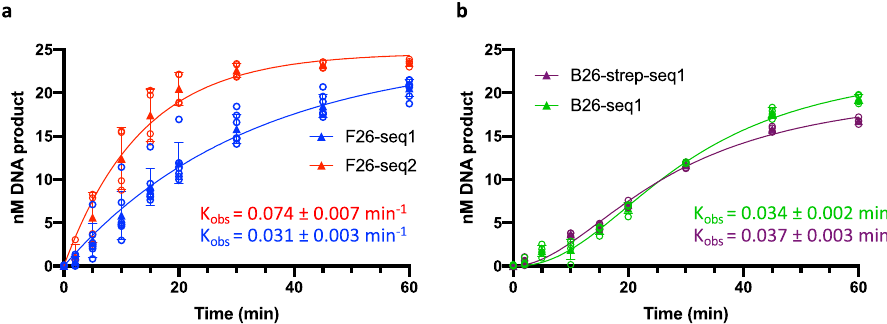
Fig. 5 Substrate speci fi city of drUvrABC. Kinetics of release of the 12 mer product by drUvrABC from either fl uorescein-conjugated DNA substrates ( a ), F26-seq1 (blue) or F26-seq2 (red), or biotin-conjugated substrates ( b ), B26-seq1 (green) or B26-strep-seq1 (plum), detailed in Supplementary Table 3. The observed rates of product release, K obs , corresponding to the rates of the dual-incision reaction, were determined for each substrate by fi tting the data points to either a single exponential model (in a ) or a sigmoidal model (in b ). a – b Reactions were performed at 37 °C using 25 nM DNA substrate, 1 µ M drUvrA1, 0.5 µ M drUvrB, and 2 µ M drUvrC in the presence of 2.5 mM MgCl 2 . Reactions were started with 2.5 mM ATP. The graphs present the mean ( fi lled triangles) and standard deviation of at least three individual replicates shown as open the binding af fi nity of drUvrA1 for the different DNA substrates used in the incision assay (Table 2 and Supplementary Fig. 6).